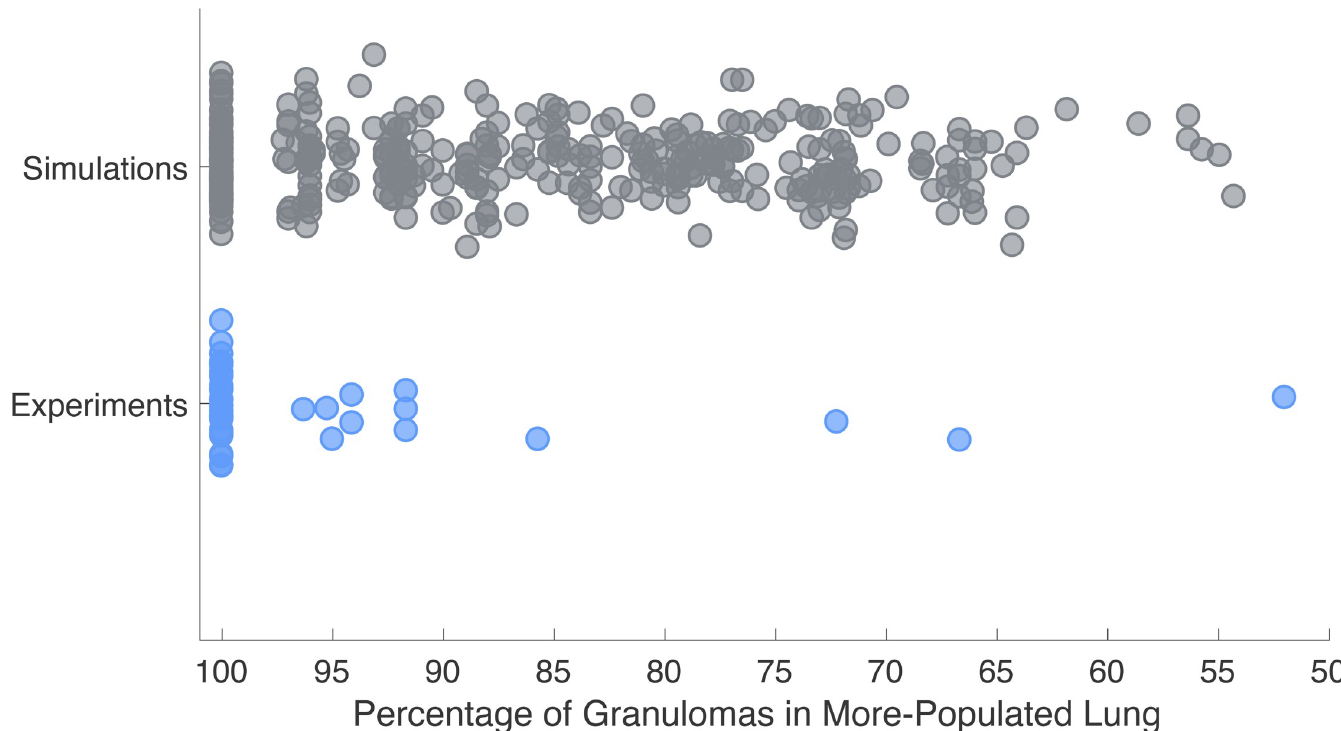
Fig 7. MultiGran recapitulates spread of infection data. At necropsy of 38 NHP experiments, we identified the lung that contained the most granulomas for each NHP. Next, we calculated the percentage of granulomas that resided in the more-populated lung out of the total number of granulomas. We found that 52–100% of granulomas formed resided within the more-populated lung. Blue dots represent each NHP experiment. We ran 200 in silico simulations that capture a similar range to the NHP spread of infection from lung to lung, ranging from 54.3% to 100%. Gray dots represent each simulated lung.